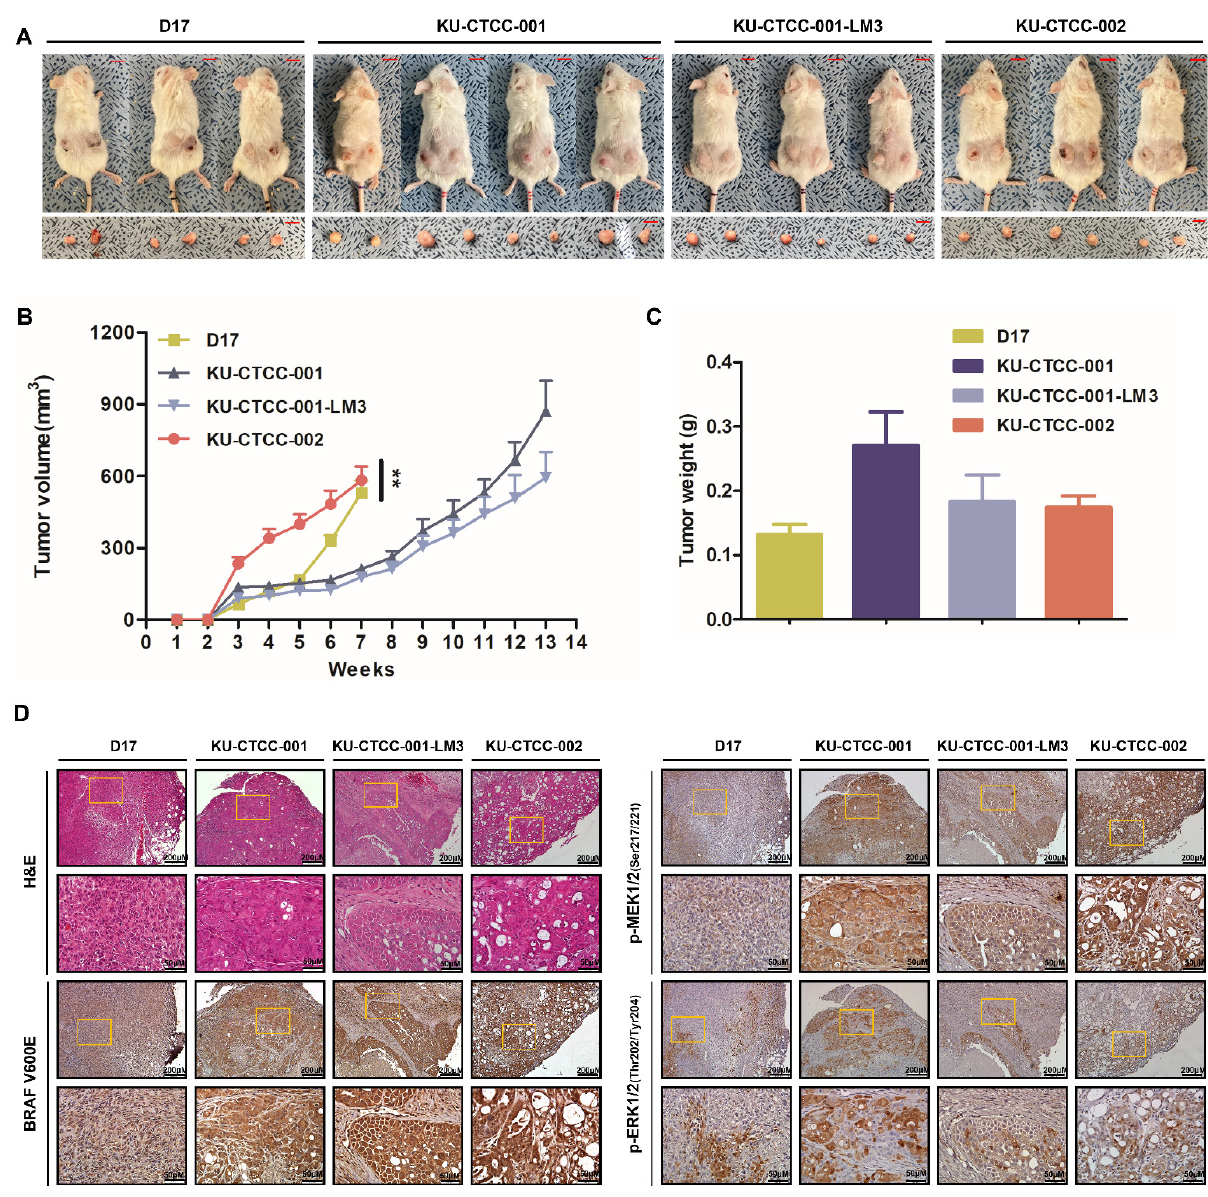
Figure 4. Tumorigenicity in the in vivo xenograft mouse model. ( A ) NOG xenograft mouse model. All cell lines showed tumorigenicity. Scale bar: 1 cm. ( B ) Growth curve of subcutaneous tumors after injection. Tumors in mice injected with KU-CTCC-002 grew faster than those of the other cell lines. As the tumor surface scar became severe, we euthanized xenograft mice injected with KU-CTCC-002 and D17 cells seven weeks after injection, before the tumor volume approached 1500 mm 3 . Error bars represent SEM. Statistical significance was determined by two-way repeated measure ANOVA; ** p < 0.01. ( C ) Tumor weight after necropsy. Error bars represent SEM. ( D ) Representative H&E and immunohistochemistry images at low (×100, scale bar = 200 μ m) and high magnification (×400, scale bar = 50 μ m). The tumors injected with TCC cell lines were more positively stained by anti-BRAF V600E antibody than those of the D17 cells. Positive staining of tumors with p-MEK1/2 and p-ERK1/2 antibodies indicated MAPK pathway activation.